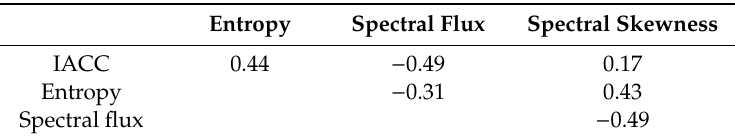
Table 1. The correlation coe ffi cients between the explanatory variables used in the multiple regression analysis in the equal L Aeq condition for the birdsongs.